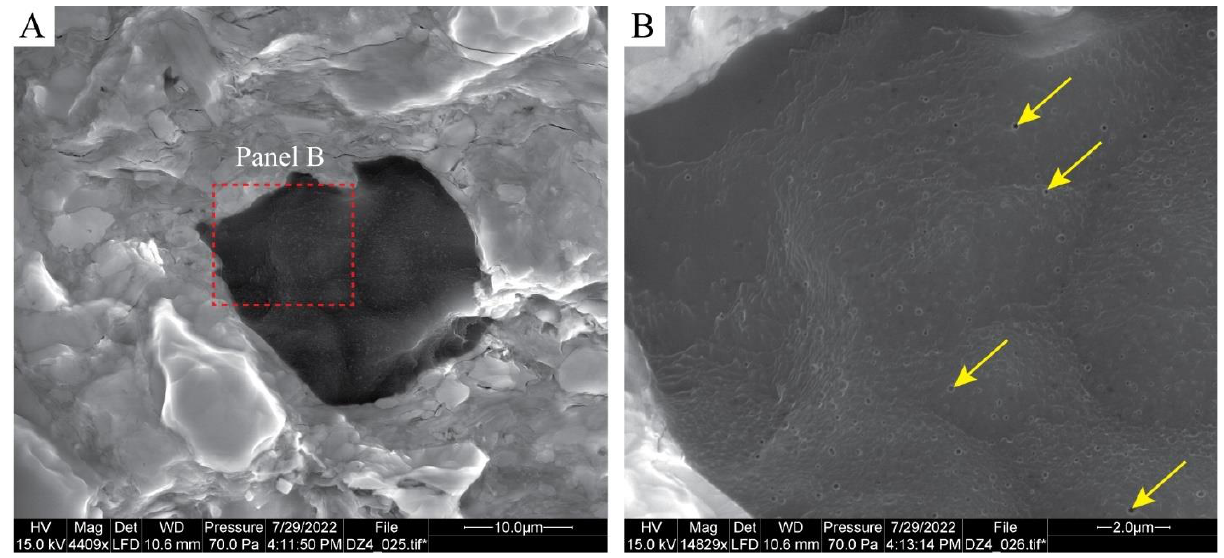
Figure 9. SEM images showing organic matter-hosted pores (yellow arrows) in the studied Chang 7 Member shale samples. The particulate OM dispersed in the shale matrix in ( A ) is most likely a terrestrial OM; ( B ) is the close-up view of the red dashed areas in (A). Sample DZ-4.